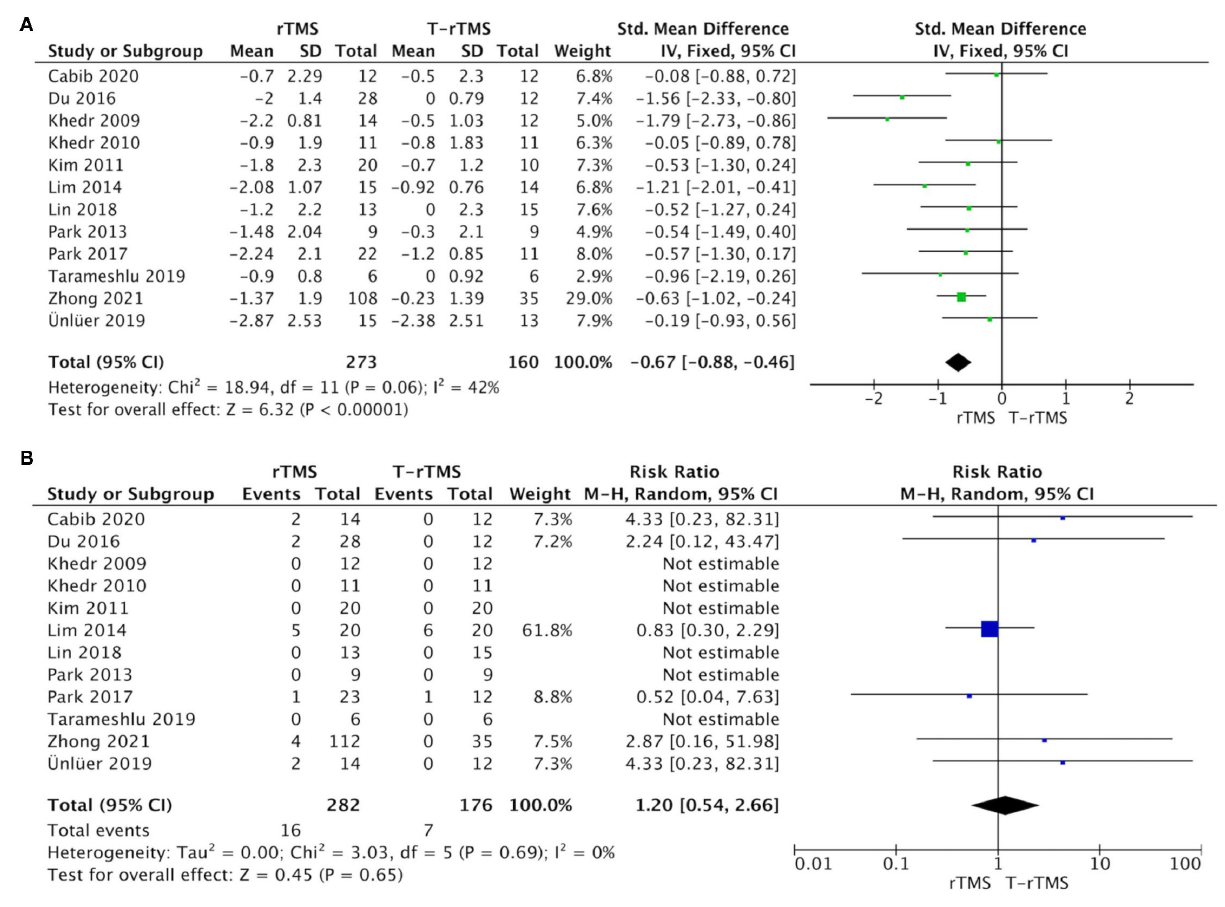
unaffected hemisphere), stimulation pattern (high